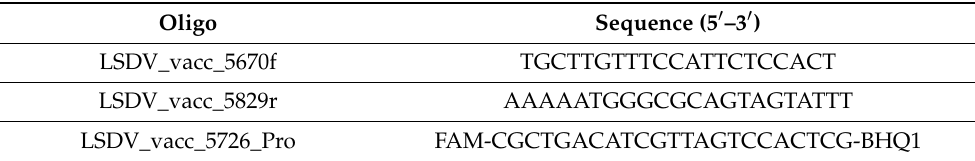
Table 2. Primers and probe for the KV-VAC assay specific for Neethling-based vaccine strains of LSD